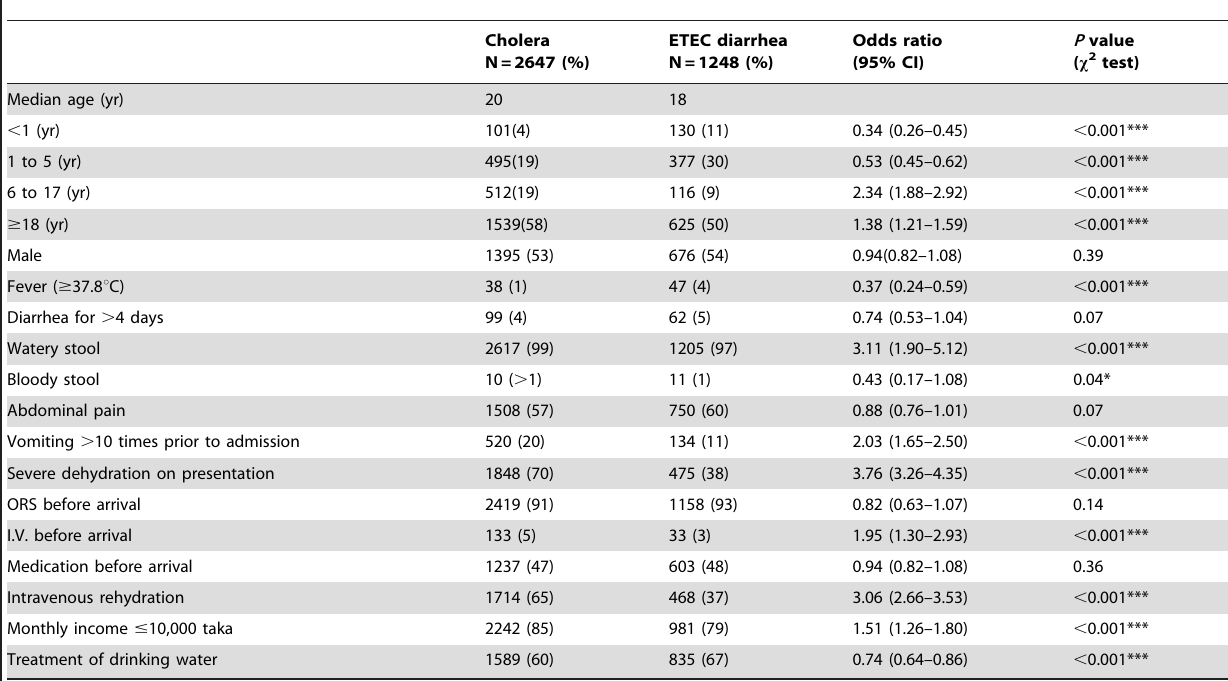
Table 2. Clinical features of cholera and ETEC diarrheal patients during study period from Mirpur.